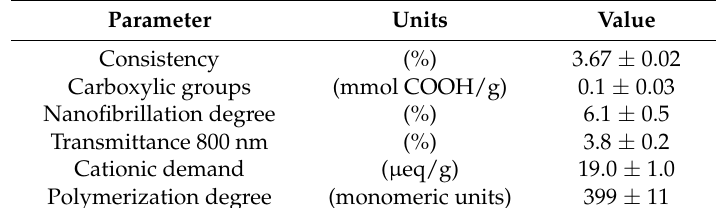
Table 1. Characteristics of cellulose microfibers (CMF).